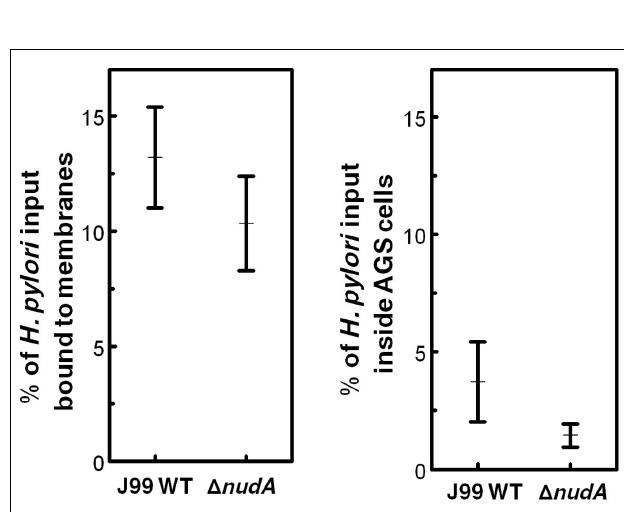
FIGURE 3 | Experimental design of the gentamicin protection assay. AGS cells were prepared to grow to monolayer in 8 wells in a 12-well plate (four wells forWT strain J99 and four wells for Δ nudA mutant. Each strain was inoculated into the four AGS cell types.Two wells (on the left) were designed as negative control of gentamicin treatment as it was added to H. pylori suspension when inoculated to the cells, and then treated with or